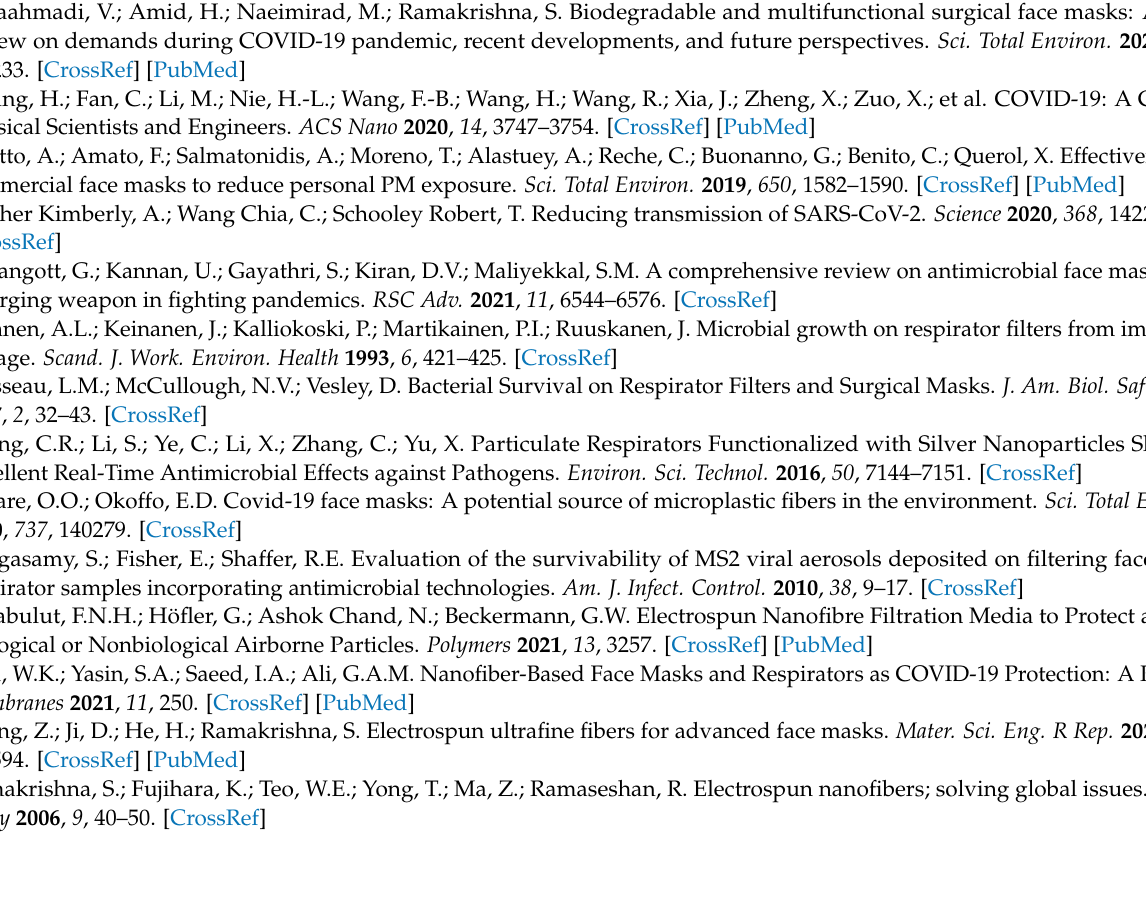
Table S3. Pressure drops values of PLA NF filter when tested against EN 14683:2019+AC:2019 test Table S5. Viral filtration efficiency of PLA NF filter media, Table S6. Filtration efficiency of PLA NF filter when challenge with 0.3 µ m NaCl particles fol-lowing ASTM F3502 test method, certified by Nelson Lab, Table S7. Filtration efficiency of PLA NF filter when challenge with 0.3 µ m NaCl Table S8. Filtration efficiency of PLA NF filter when challenge with 0.3 µ m NaCl particles fol-lowing NIOSH—42CFR84 test method, certified by Nelson